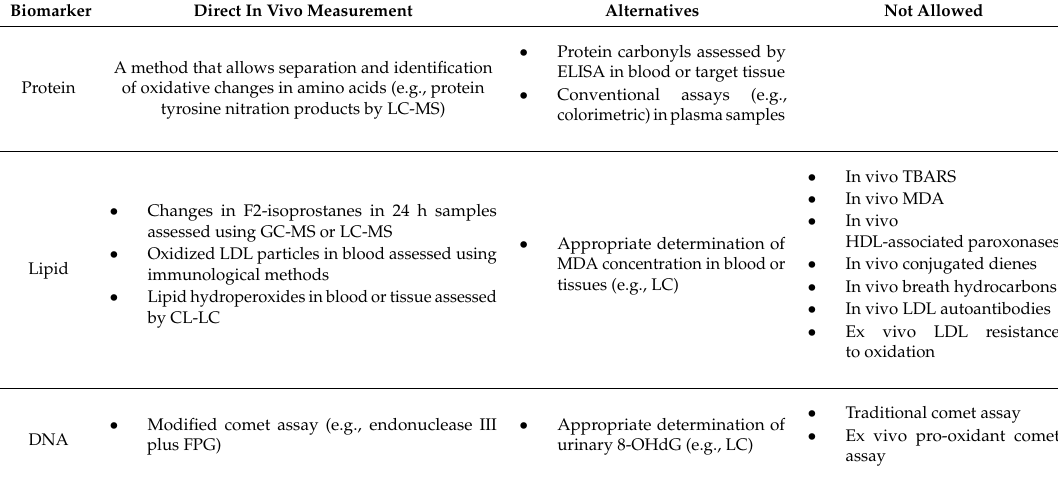
Table 2. Biomarkers approved by the European Food Safety Authority